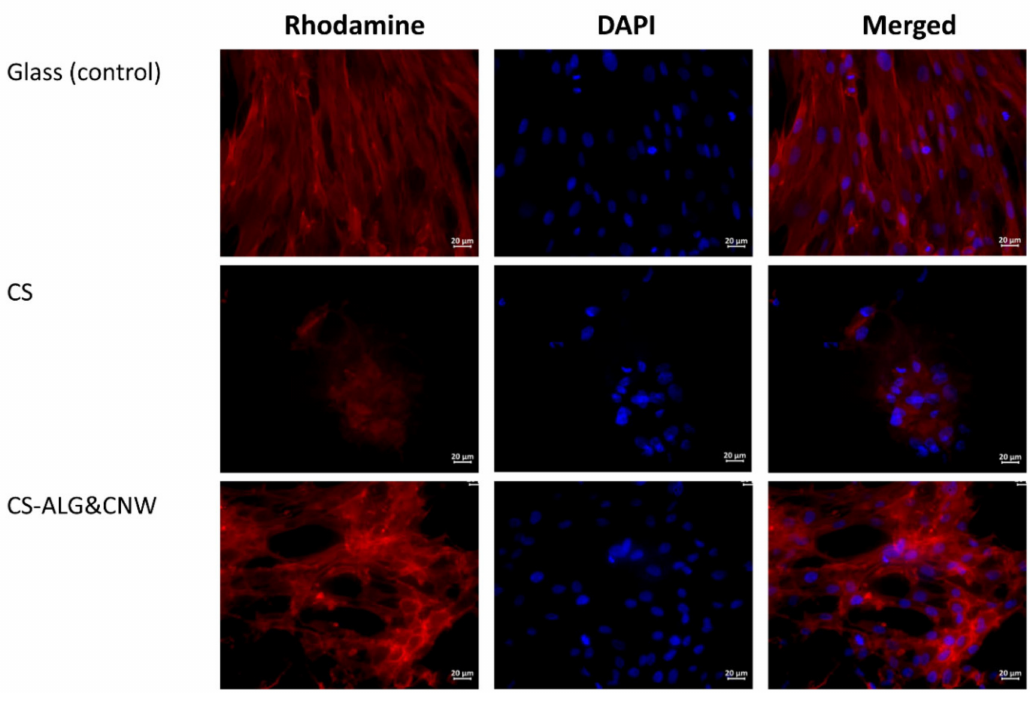
Figure 6. Multipotent mesenchymal stem cells (MMSCs) adhered onto the surfaces of cover glasses and sca ff olds. Vinculin in the cell cytoskeletons was stained with a fluorochrome (rhodamine channel); cell nuclei were stained with 4 (cid:48) ,6-diamidino-2-phenylindole (DAPI). Combined two-channel image. Magnification × 40.